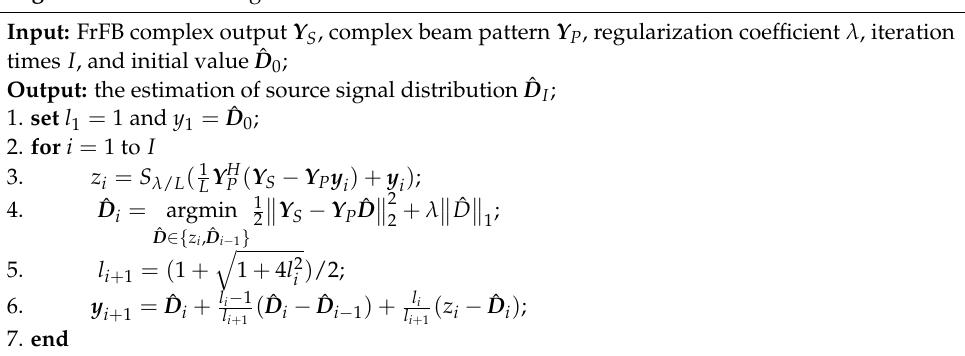
Algorithm 1: MFISTA